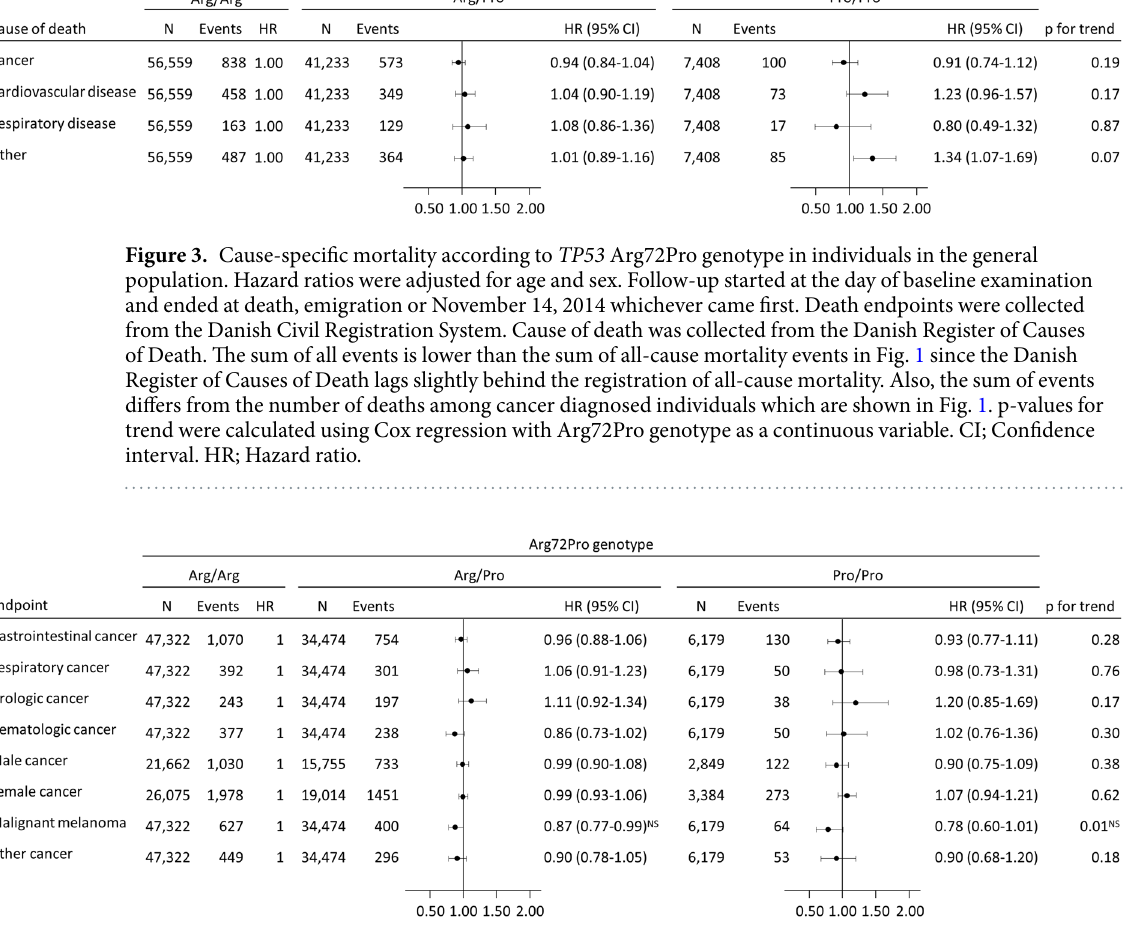
Figure 4. Risk of cancer according to TP53 Arg72Pro genotype in individuals in the general population. Hazard ratios were adjusted for sex and age. Follow-up started at the day of birth or for individuals born before 1943 at the start of the national Danish Cancer Registry and ended at cancer diagnosis, death, emigration, or December 31, 2012 whichever came the first. p-values for trend were calculated with Cox regression using Arg72Pro genotype as a continuous variable, and the nominal values are shown without prior adjustment for multiple comparisons. NS Insignificant after Bonferroni correction for 8 multiple tests. Required p-value = 0.006 CI; Confidence interval. HR; Hazard